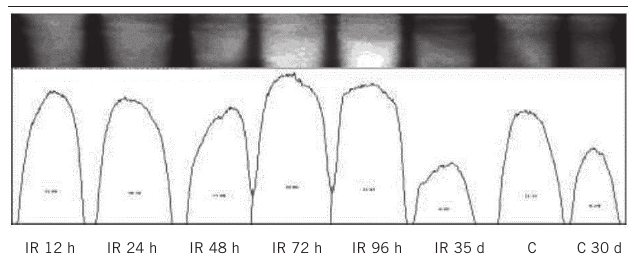
figurE 6 − Electrophoretic profile of SG1 proteins after whole-body exposure to 5 Gy SG1: subgroup 1.